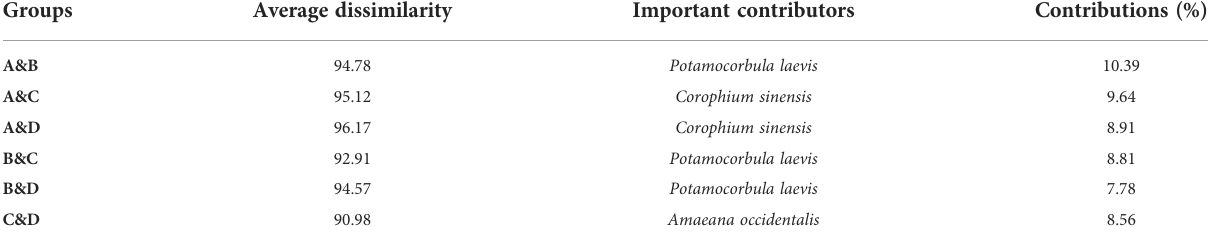
TABLE 1 Average dissimilarity and most important contributors.